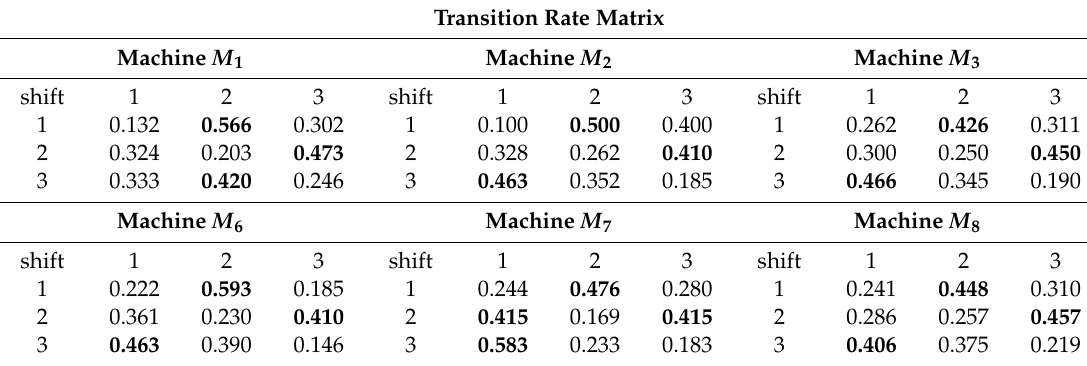
Table A1. The transition rate matrix for each machine in the production system. Bold numbers represent the highest probability of the machine